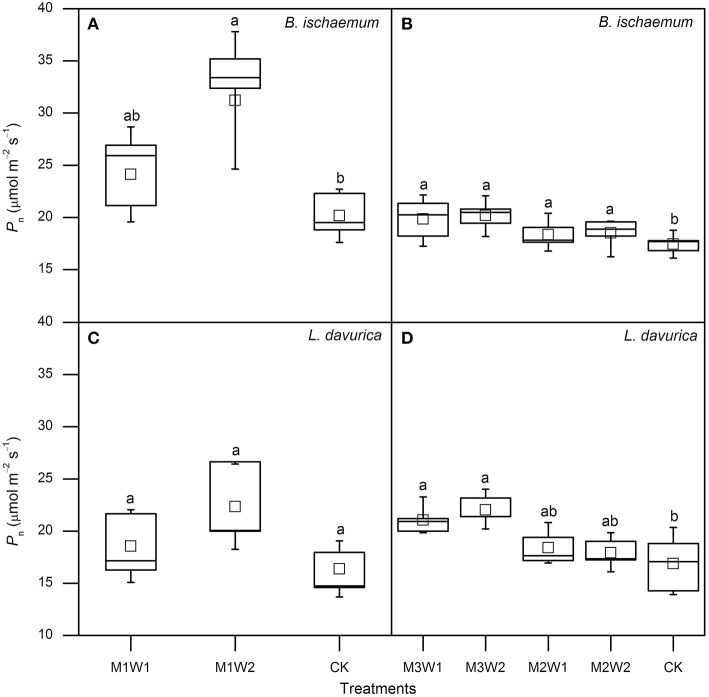
The net photosynthetic rates (Pn) of Bothriochloa ischaemum and Lespedeza davurica under each treatment after watering in July (A,C) and August (B,D). Data derived from 5 days after watering, and squares in boxes indicate averages of 5 days. The lowercase letters above boxes indicate significant differences between treatments (P < 0.05).